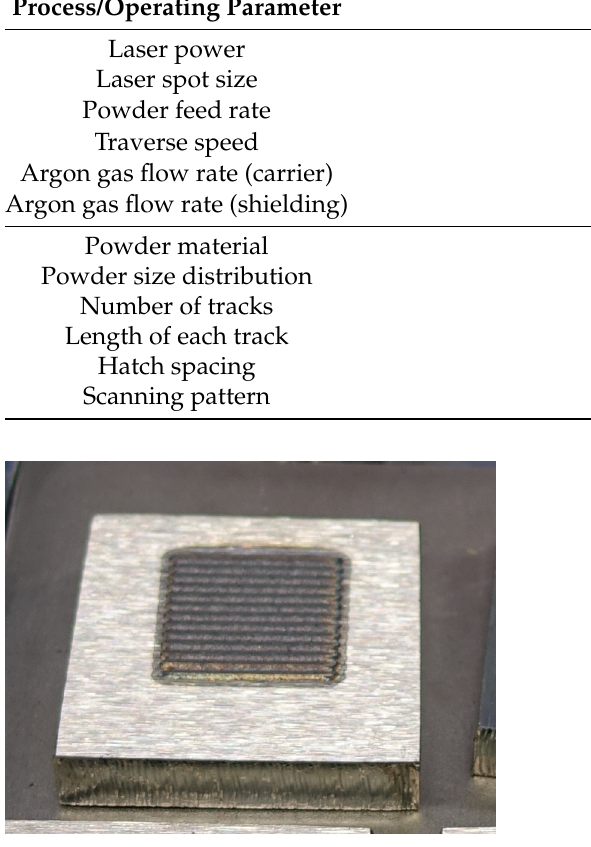
Figure 3. Produced